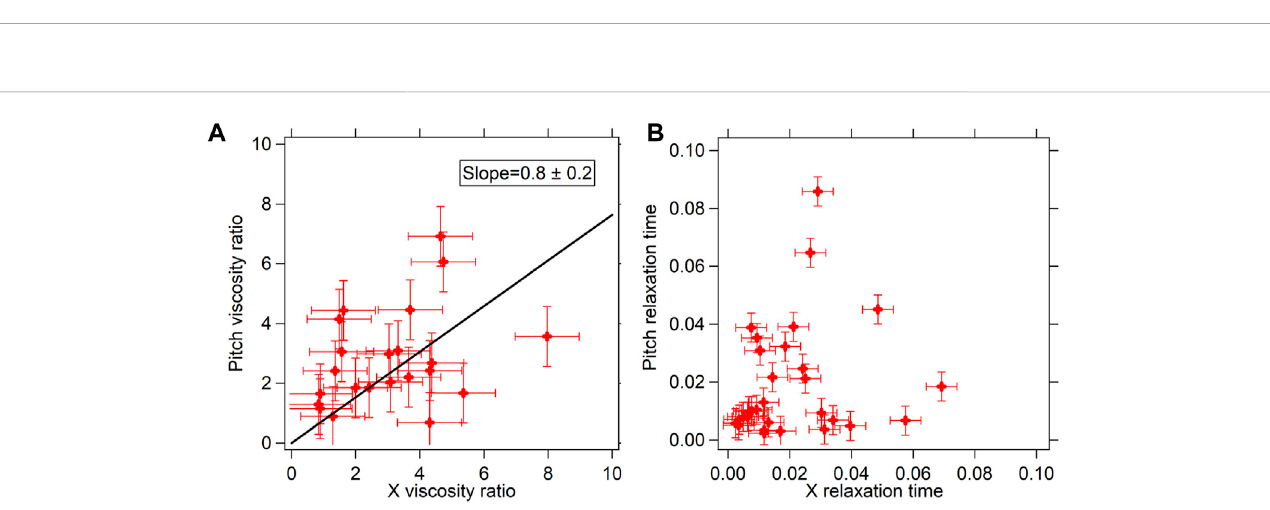
+ 1 (cid:2) 2 ± 1, λ = .007 ± .002 s for pitch rotational mode μ s